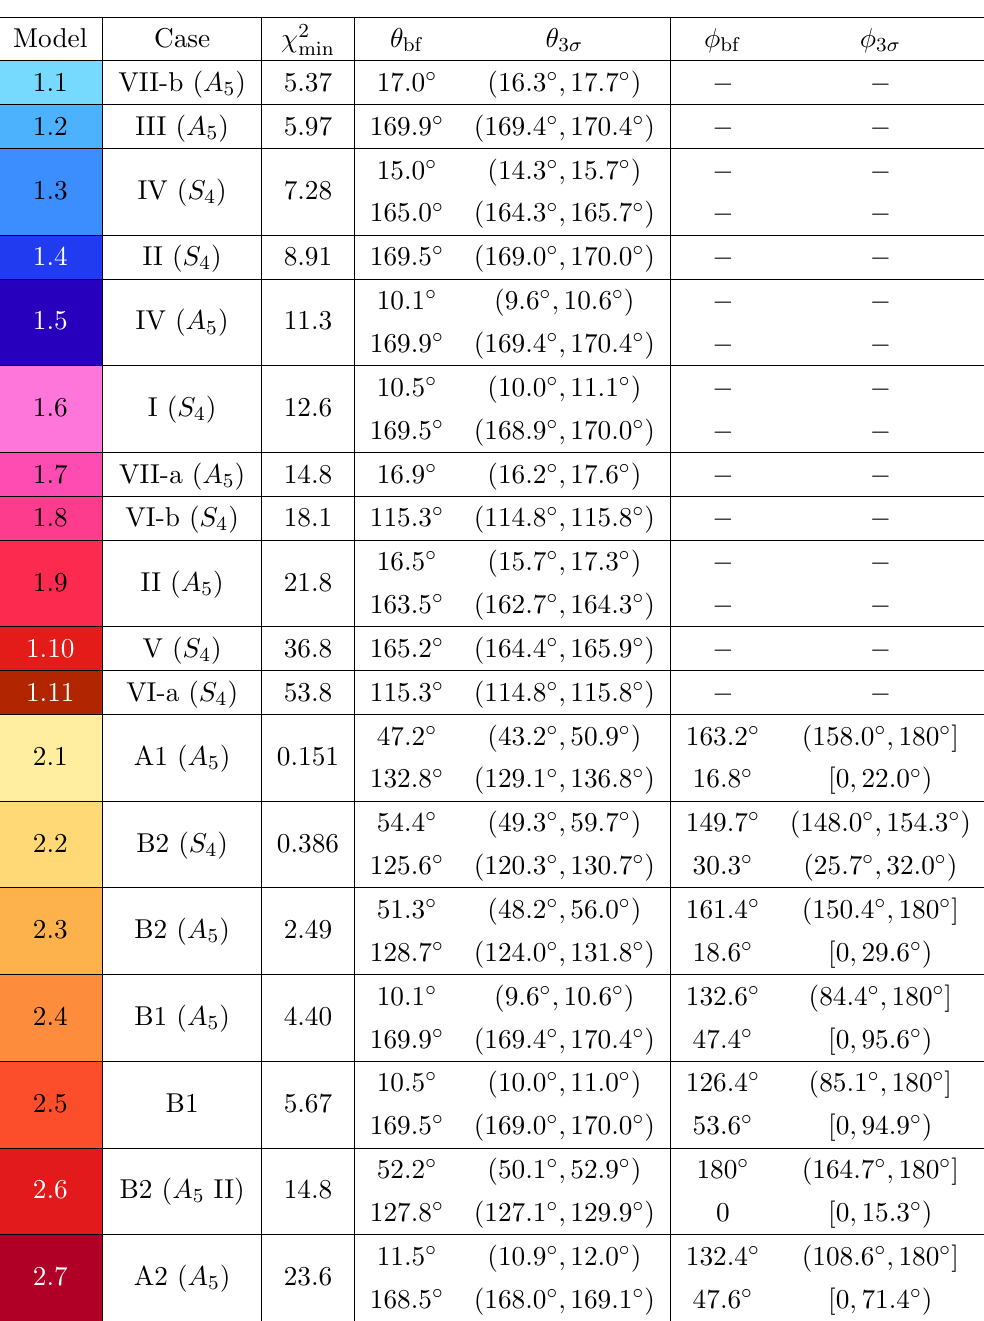
Table 8 . Fits of the 18 one- and two-parameter models to global neutrino oscillation data from NuFIT 4.1 (July 2019, NO with SK atmospheric data) [73]. See also table 7. Note that there are four degenerate best-(cid:12)t points ( (cid:18) bf ; (cid:30) bf ) for each two-parameter model (i.e., Models 2.1{2.7) that lead to the same value of the (cid:31) 2 function. Two best-(cid:12)t points are presented for each model and min the other two can be found performing the replacement rule (cid:30) bf 2 (cid:25) (cid:30) bf . In addition, the two ! (cid:0) presented best-(cid:12)t points for each model are related by the simultaneous replacement of (cid:18) bf (cid:25) (cid:18) ! (cid:0)